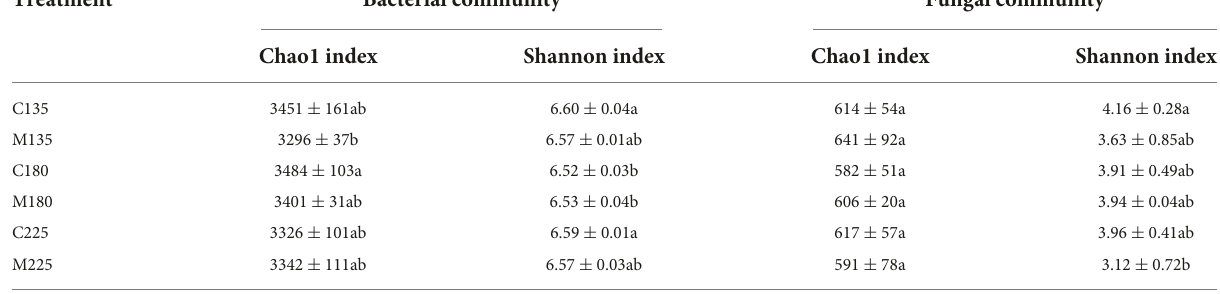
TABLE 1 Soil microbial community alpha diversity indices under different nitrogen and manure